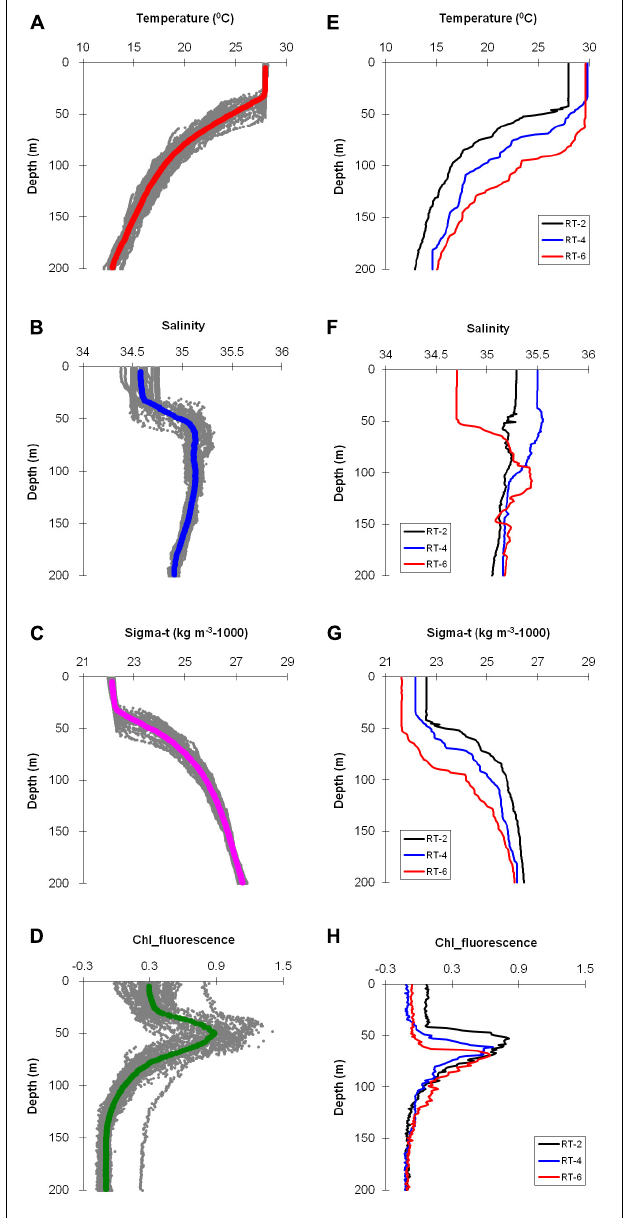
FIGURE 2 | Vertical profiles of hydrographic parameters at TS (A–D) and RT (E–H) stations measured by CTD profiling. The solid line in time series profiles indicates mean value, whereas the dotted profiles denote all the casts performed. Legends for RT stations are given in respective figures.